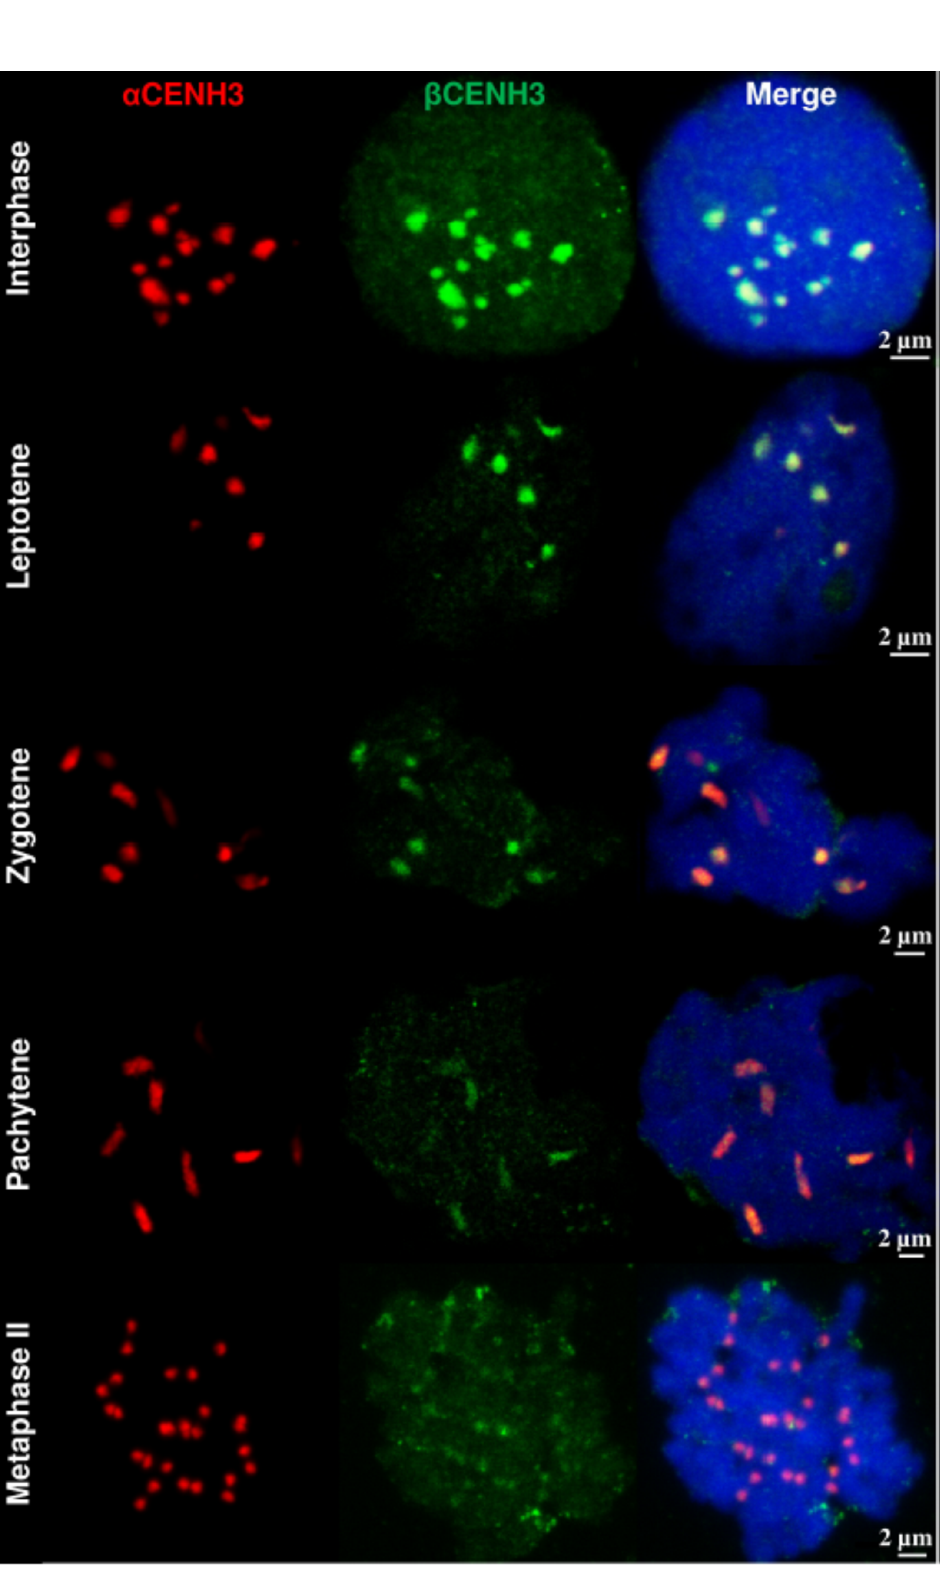
Figure 6. Loading the α CENH3 and β CENH3 proteins into rye chromosomes in meiosis.CENH3 variant-specific antibodies in combination with laser confocal scanning microscopy were used for analysis of meiotic stages in young anthers.